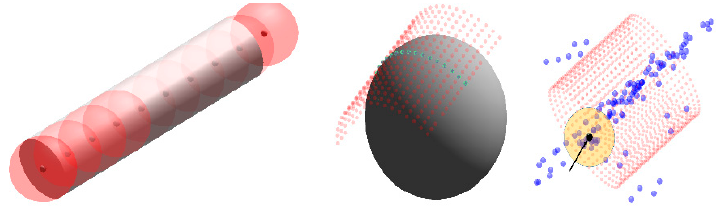
Figure 4. Center estimation using the trace of a sphere.